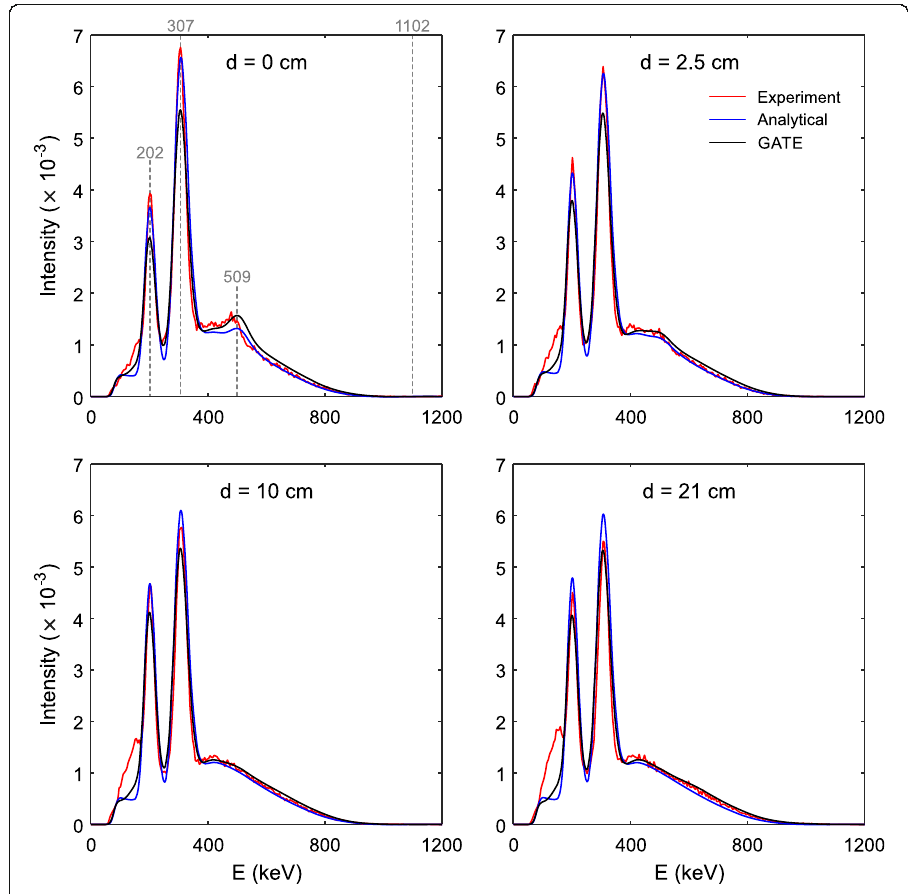
Fig. 6 Normalized coincidence energy spectra of two LYSO crystals (57.4 side length) as measured experimentally (red), simulated with GATE (black), and calculated analytically (blue) for four crystal separation